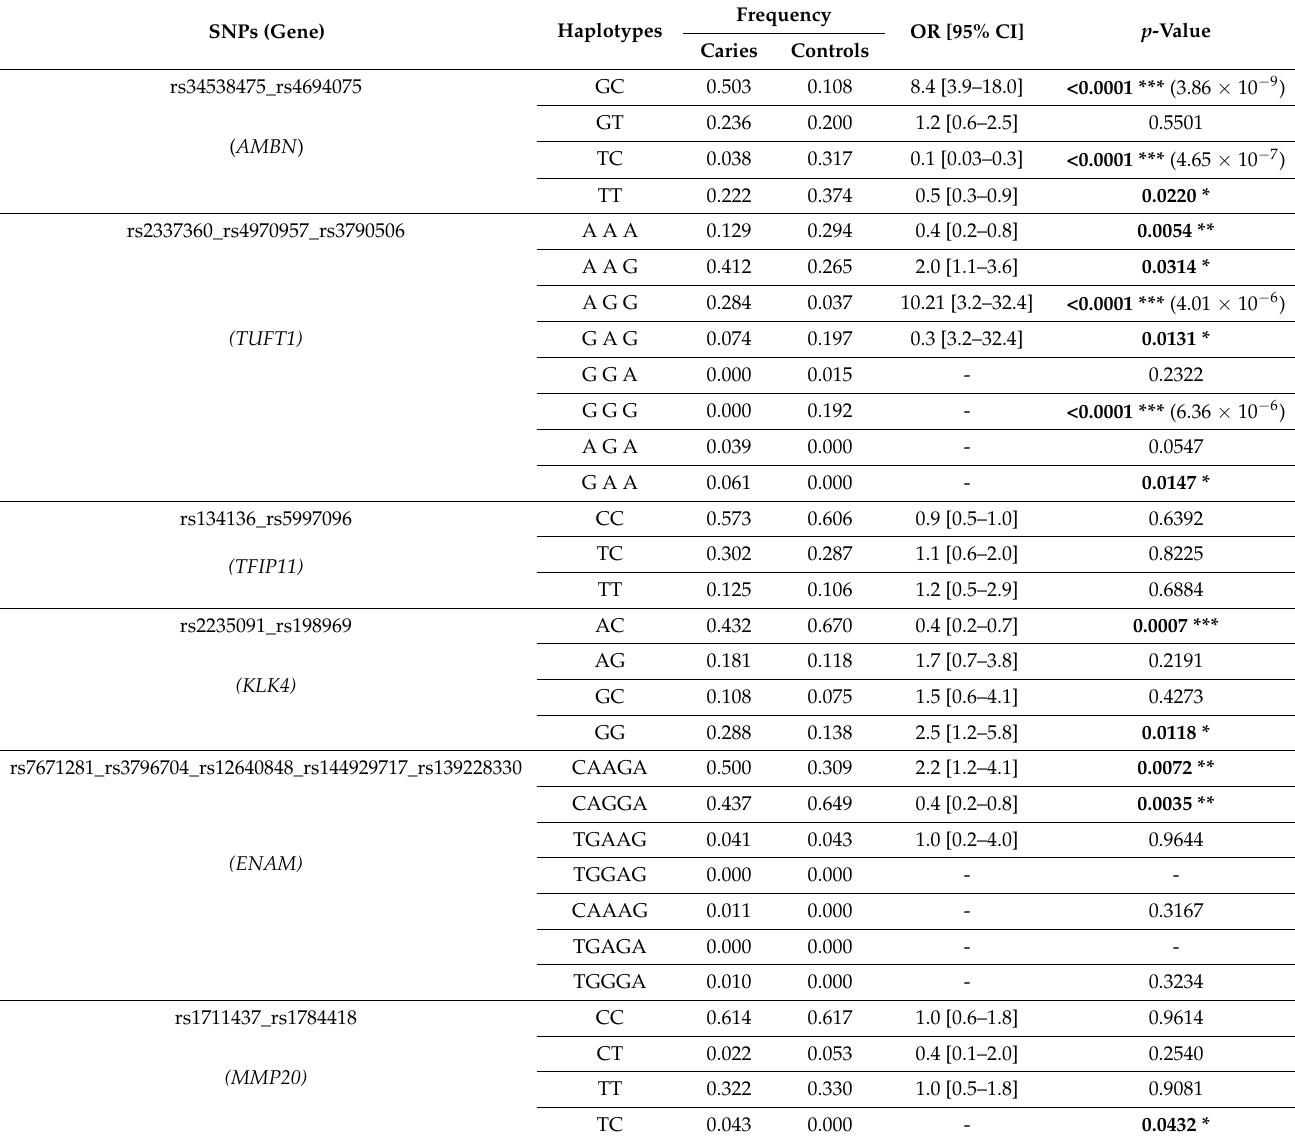
Table 5. Haplotypes distribution in caries and caries-free individuals in this